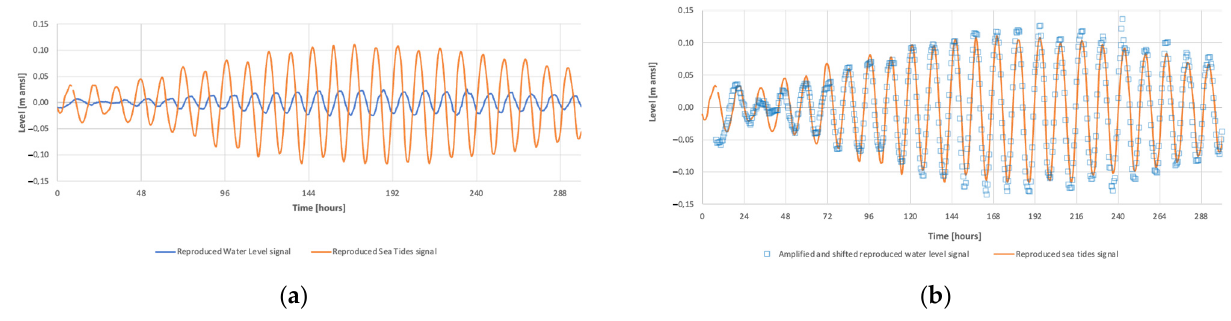
Figure 7. Reproduced water levels and sea tides signal obtained by applying the inverse FFT on the selected frequency range of the spectra from 1.8 to 2.2 waves/d ( a ) and reproduced sea tides signal plotted with the reproduced piezometric signal amplified by TE and shifted by Δ T equal to about 3.5 h ( b ).